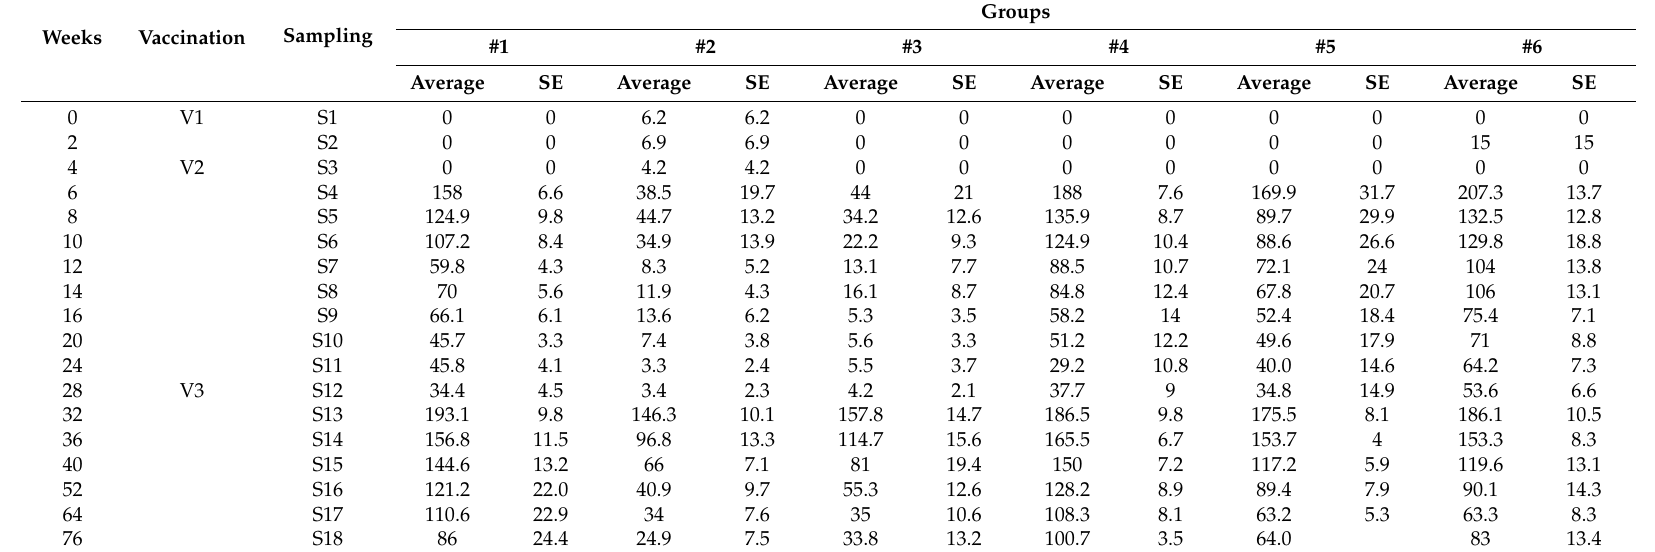
Table 3. SRH antibody titres per group and sampling date (average and standard error, titres expressed as mm 2